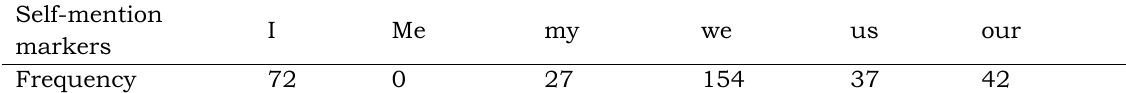
Table 2. Frequency Analysis of Self-Mention